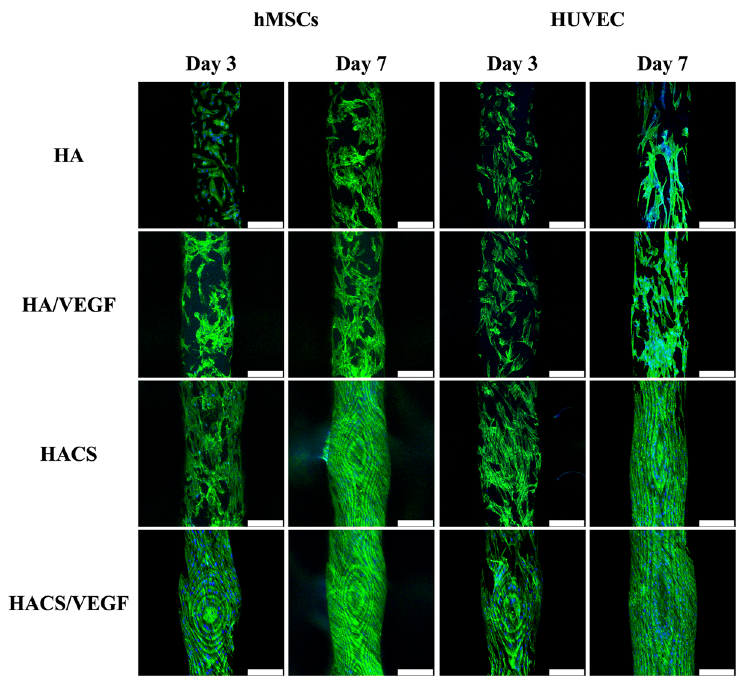
Figure 6. The F-actin filaments (green) and nuclei (blue) staining of hMSCs and HUVECs cultured on the scaffolds for 3 and 7 days. The scale bar is 400 µm.